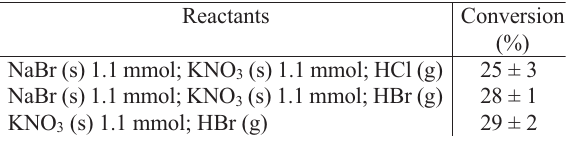
Table 1. Acetanilide bromination in the reaction